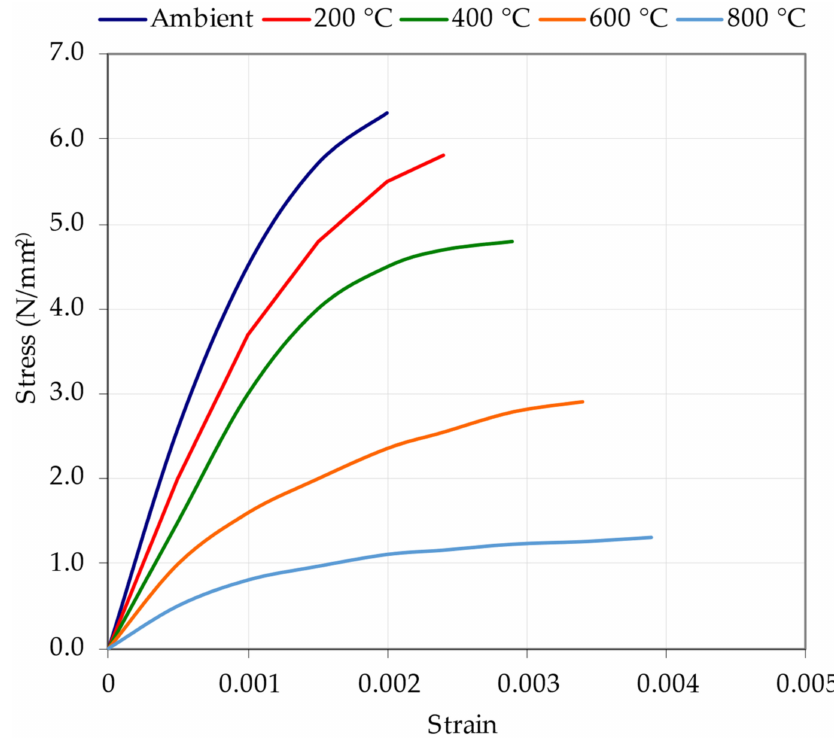
Figure 12. Stress–strain relationship for 1500 kg/m 3 density at varying temperatures.